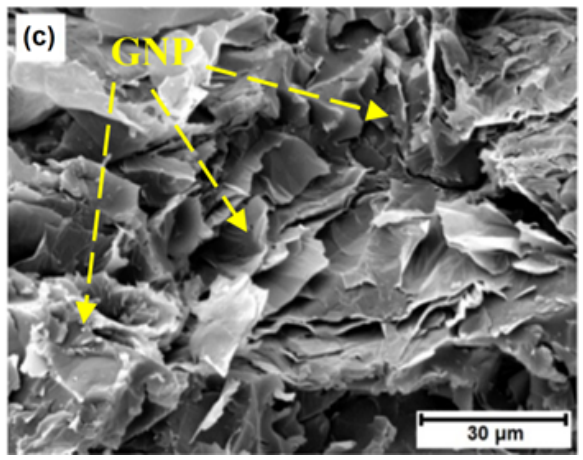
Figure 12. SEM of fracture surfaces of GNP/epoxy nanocomposites with 10.0 wt % ( a ) GNP H-5; ( b ) GNP H-15; ( c ) GNP H-25.